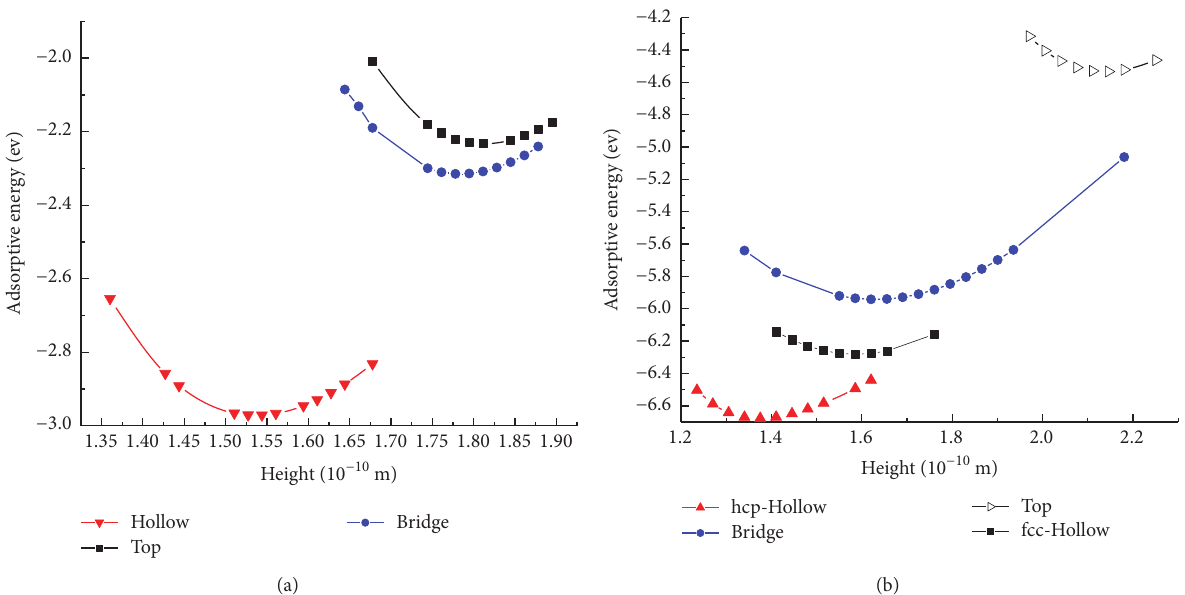
Figure 3: The variations of adsorption energies at different sites with different height. (a) The Co adatom at graphite. (b) The Co adatom at SiC.